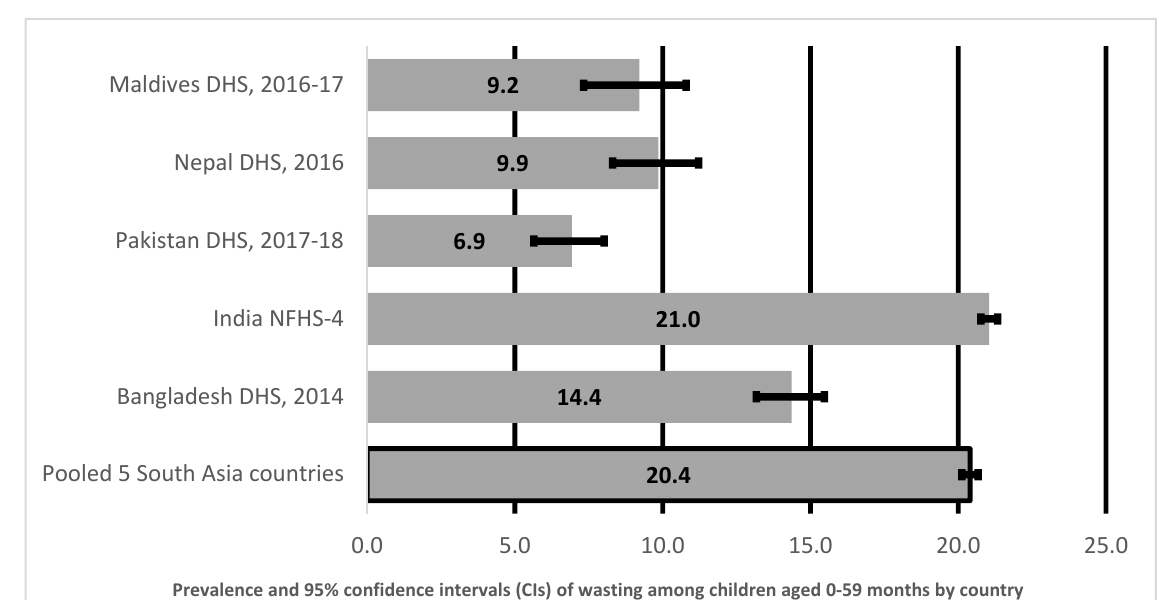
Figure 3. Prevalence and 95% confidence intervals of wasting in children aged 0–59 months in South Asia.